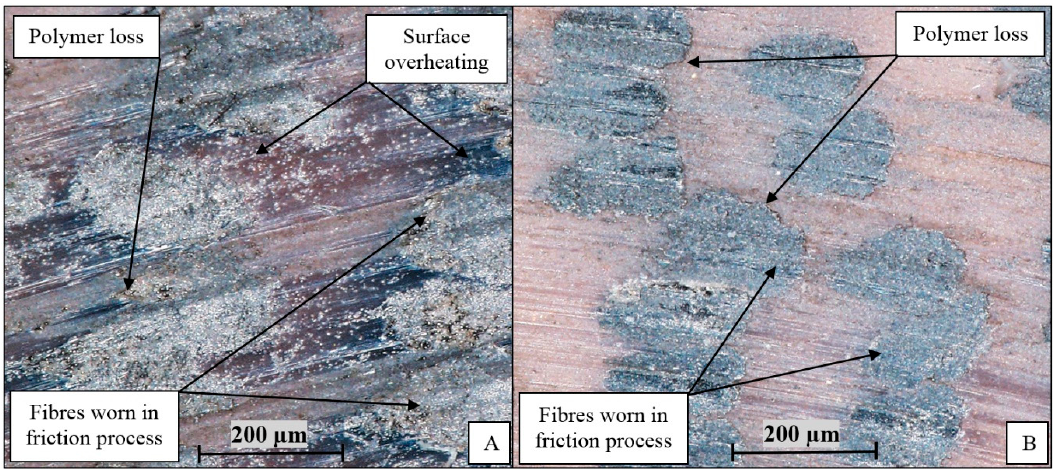
Figure 9. The surface after testing the tribological wear of the composite formed at temperature: ( A ) 225 °C, ( B ) 235 °C.